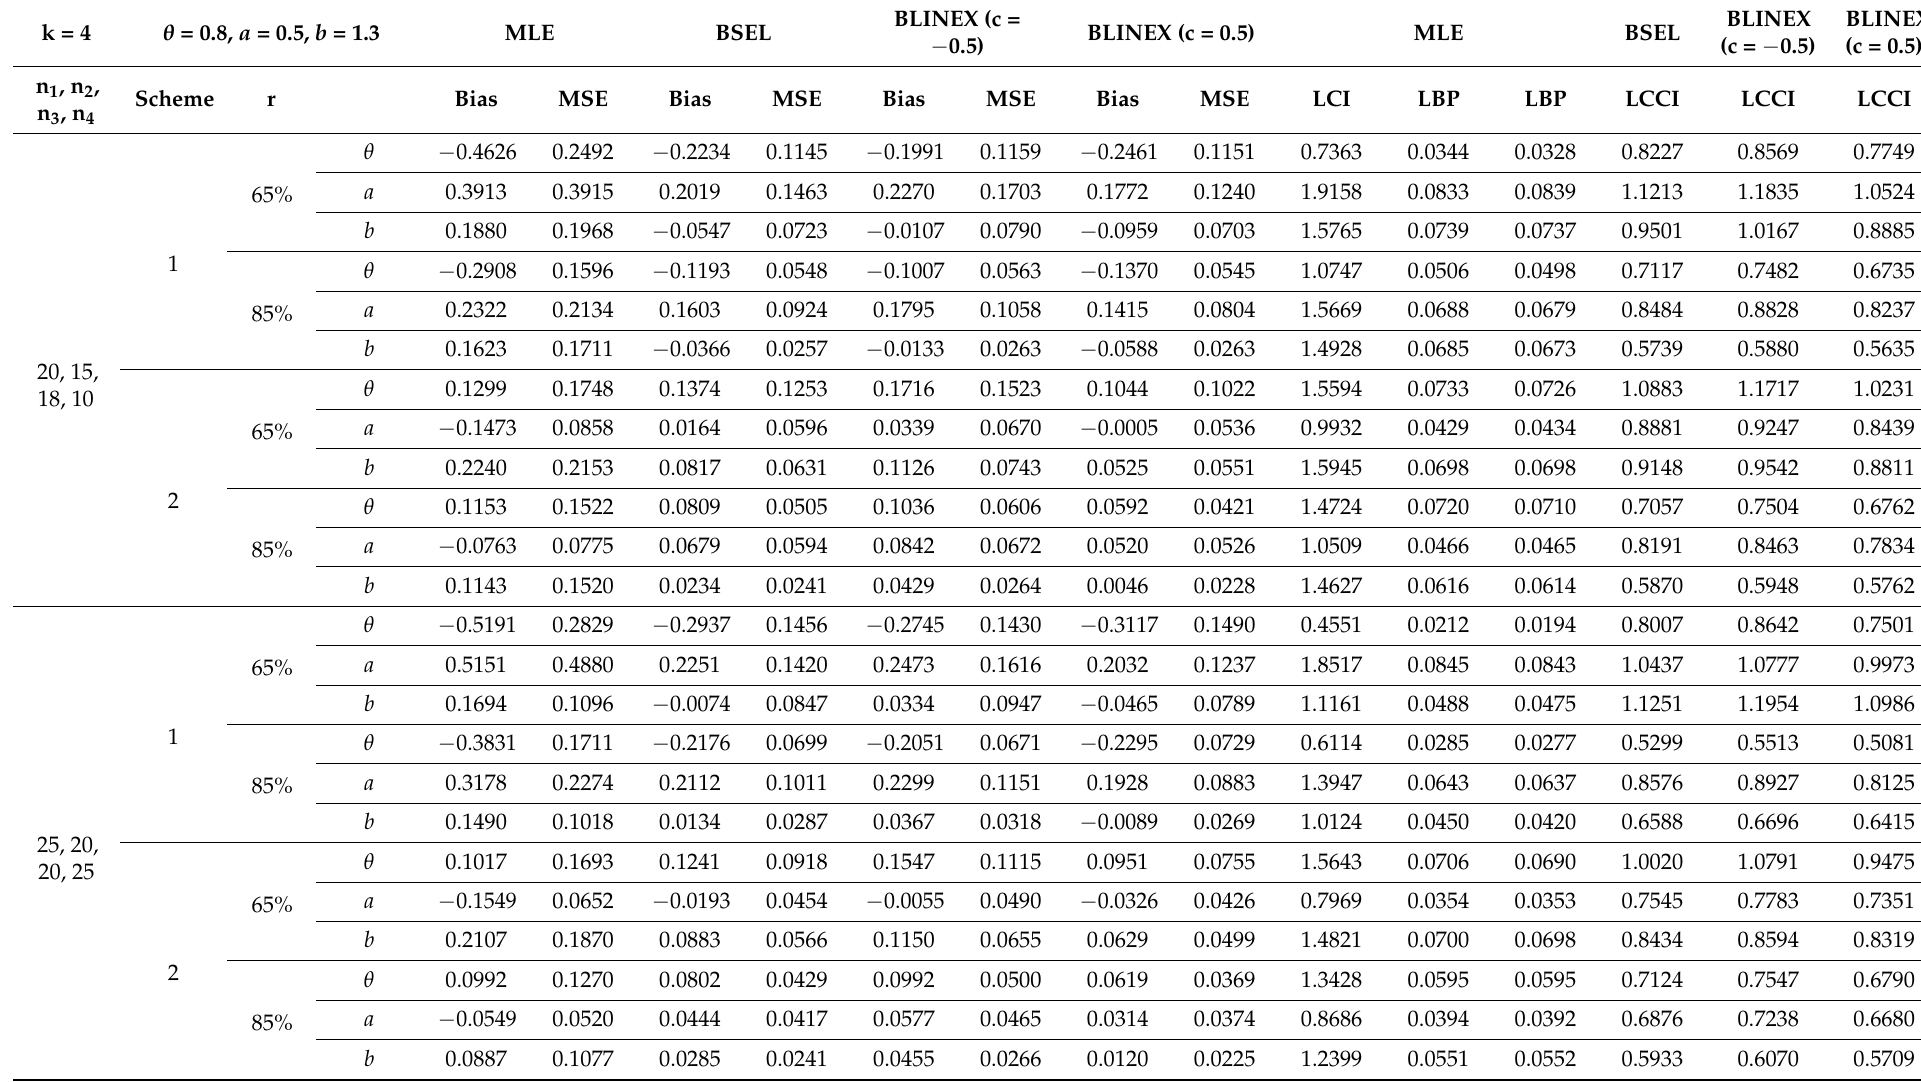
Table 5. MLE and Bayesian estimation with different loss functions in multi ramp when θ = 0.8, a = 0.5, b =